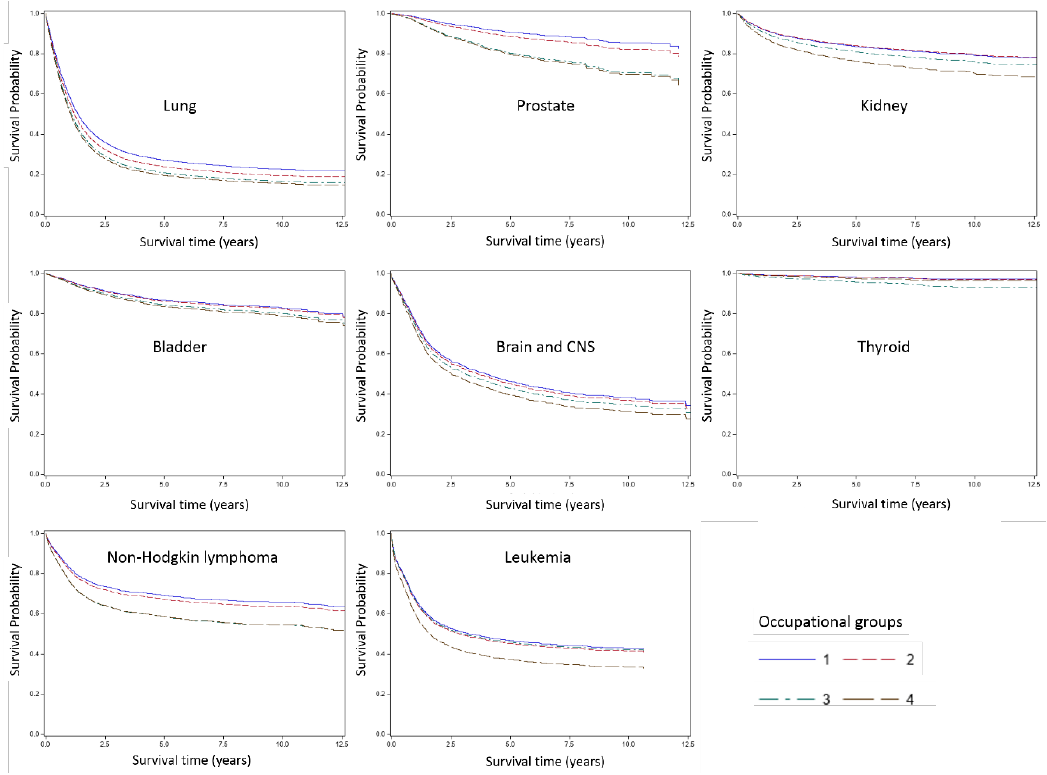
Figure 2. Survival curve by occupational group and cancer site. Group 1, Professionals and managers; Group 2, Clerks; Group 3, Service and sales workers; Group 4, Blue-collar workers.